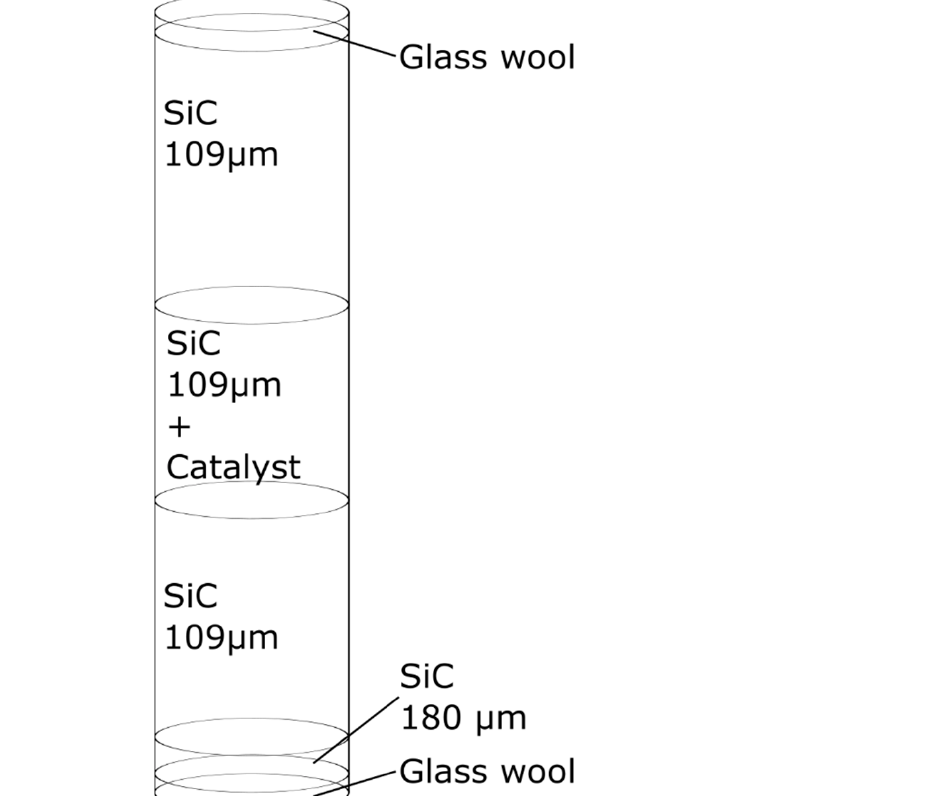
Figure 11. Schematics of the experimental setup.